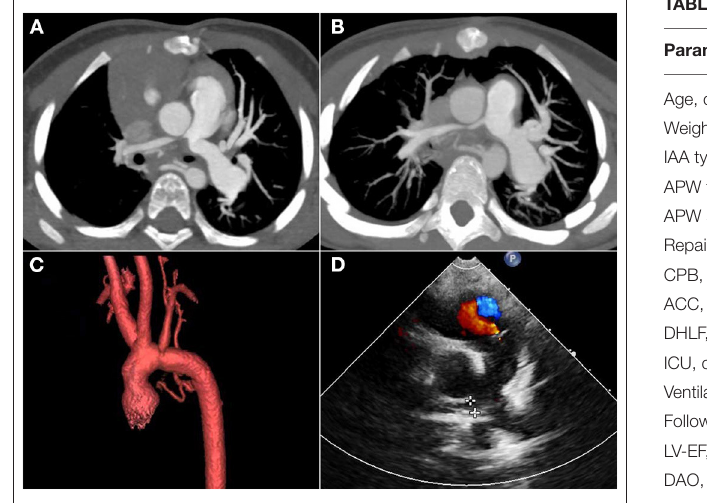
FIGURE 3 | Post-operative follow-up images of patient No. 2. (A) CT images showed that ascending aorta oppressed the opening of RPA and LPA 12 months after the primary operation. (B) CT images showed RPA stenosis again 6 months after the first re-operation. (C) The post-operative three-dimensional imaging of the aortic arch showed that the aortic arch and its branches were in good shape. (D) The latest ultrasound images showed good development of RPA with a gradient of 9 mmHg. RPA, right pulmonary artery; LPA, left pulmonary artery.